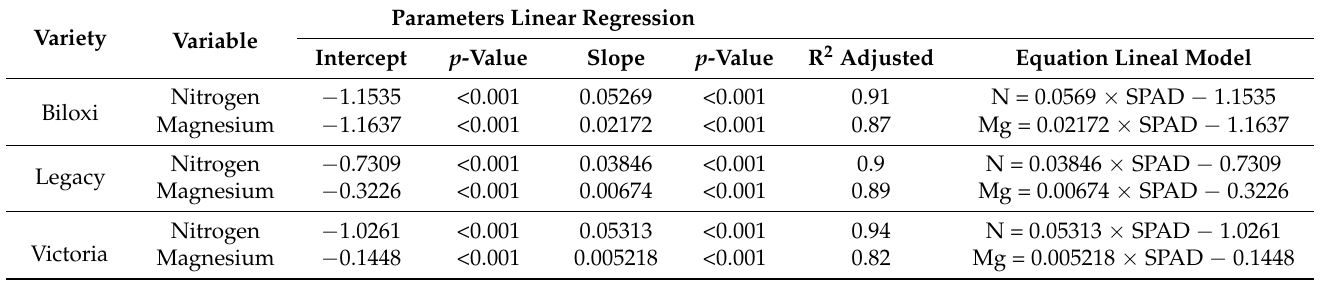
Table 2. Linear regression parameters between SPAD units and nitrogen and magnesium content in three blueberry cultivars under conditions of the Colombian high tropics.